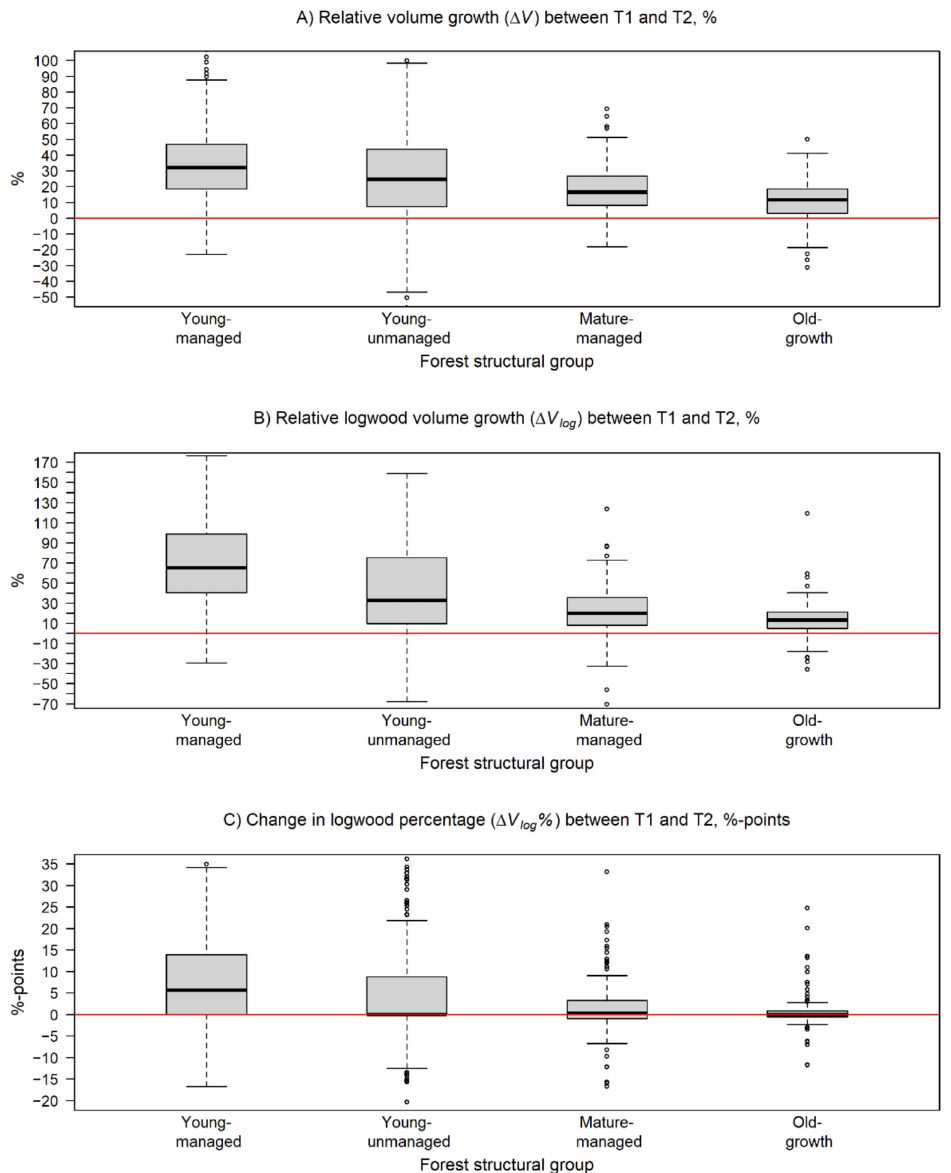
Figure 5. Box and whiskers plots describing the variation in change of the estimated stem volume attributes within the forest structural groups during the monitoring period. In the plots, the black line represents the median of change and the box borders show the lower and upper quartile of the variation. The whiskers are used to indicate 1.5 times the interquartile range from the upper and lower quartiles. In ( A ), the relative change in stem volume ( ∆ V ) and, in ( B ), the relative change in logwood volume ( ∆ V log ) are presented in percentages. In ( C ), the change in logwood percentage of tree stems ( ∆ V log % ) is reported in percentage points. The horizontal red line is equal to no